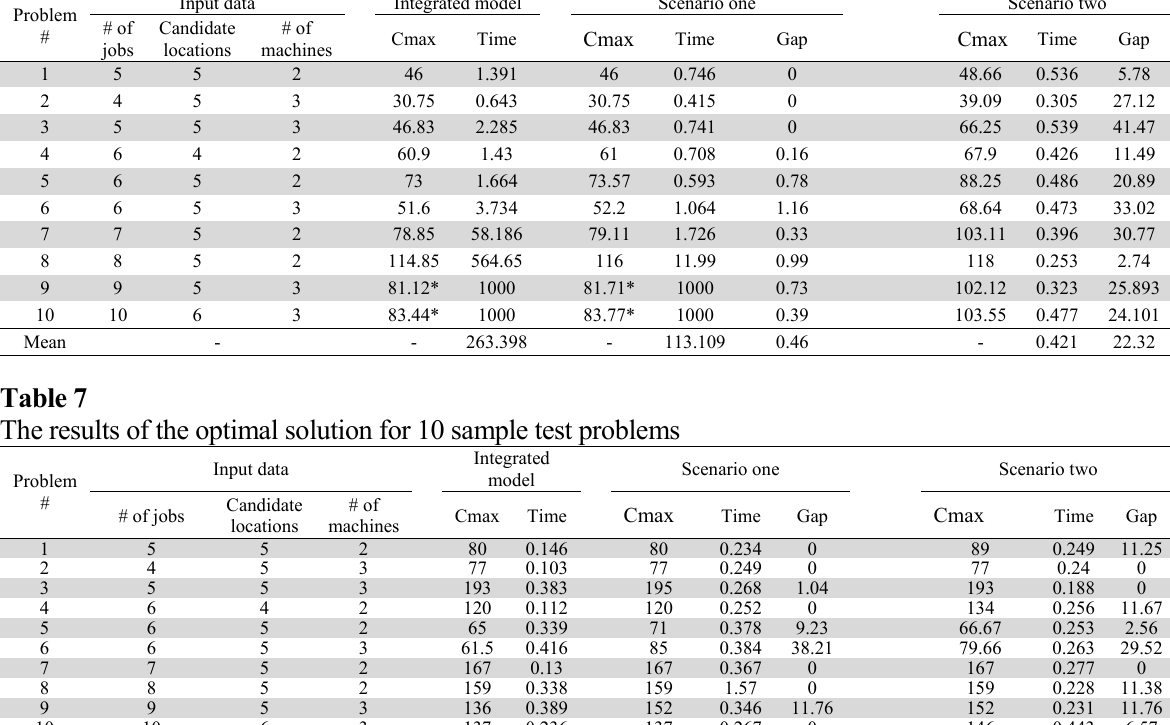
The results of the optimal solution for 10 sample test problems Problem #